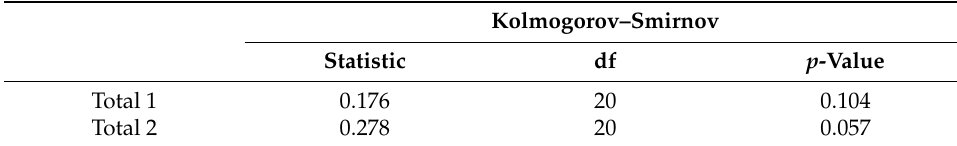
Table 2. Tests of normality.